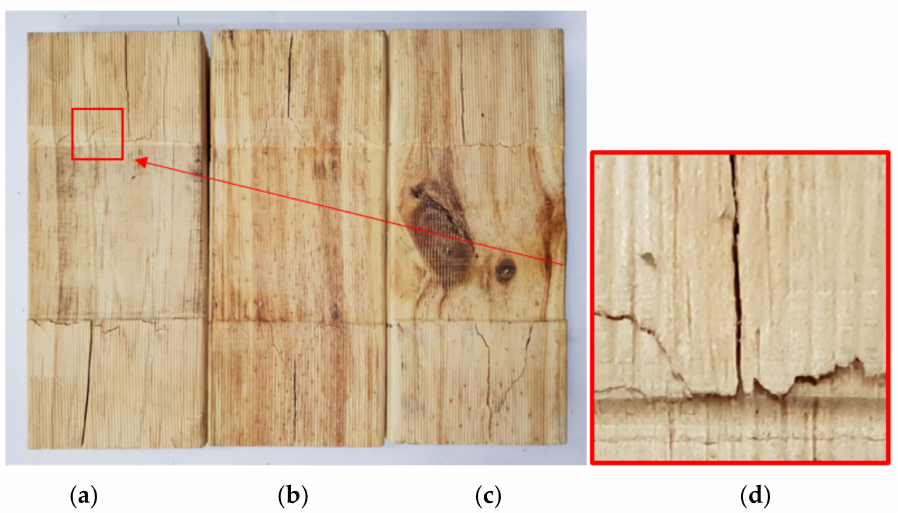
Figure 18. Some typical CPerpG failures in ( a ) clear, ( b ) resin and ( c ) knots ( d ) shows shearing failure at edge of plates.